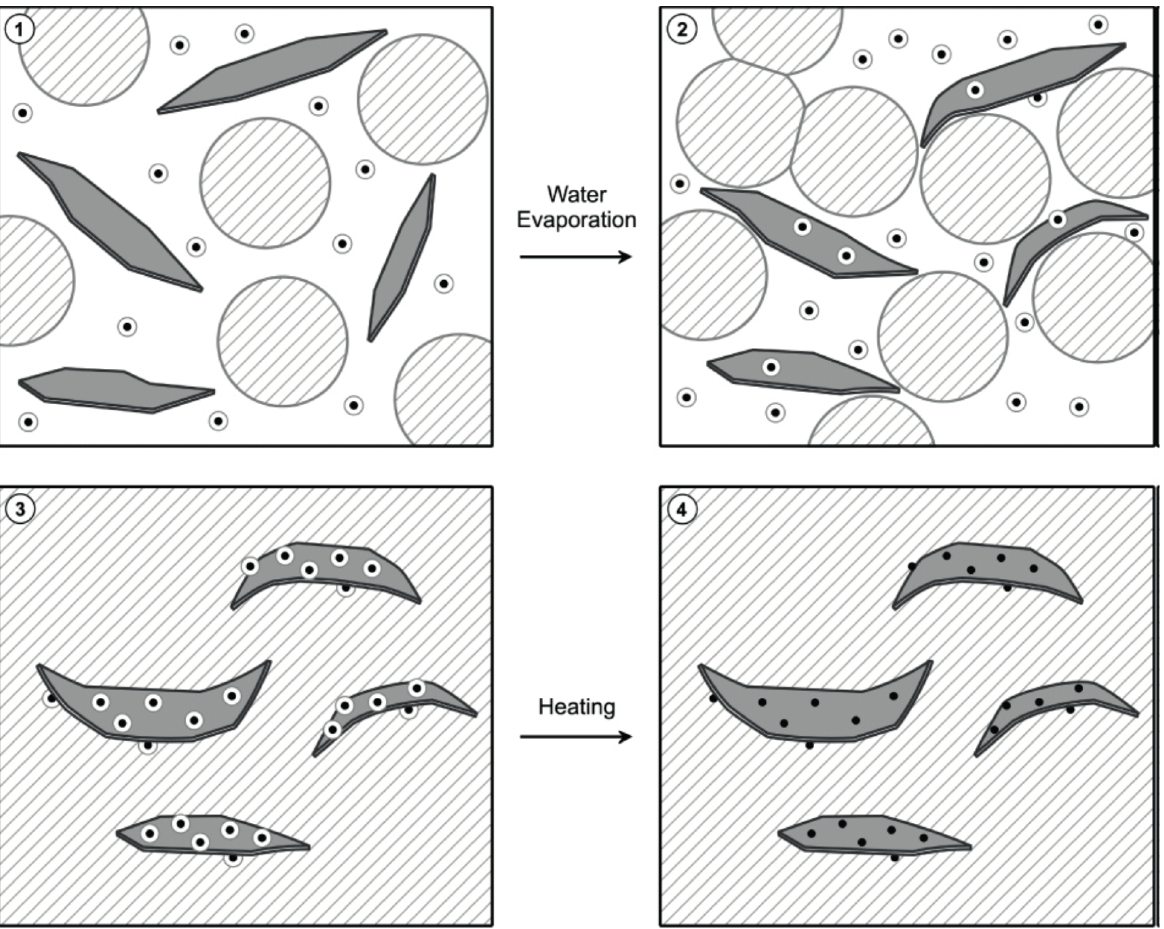
Figure 5 - Schematic representation of the role of positive counterions (small circles) on the adhesion between clay lamellae and polymer. (1) latex and clay dispersion, (2) polymer-clay particles approach during dispersion drying, (3) hydrated counterions bridging clay and the dry polymer matrix, and (4) dehydrated counterions bridge clay lamellae and the polymer matrix. Reprinted (adapted) with permission from Bragança et al. 2007. Copyright (2007) American Chemical